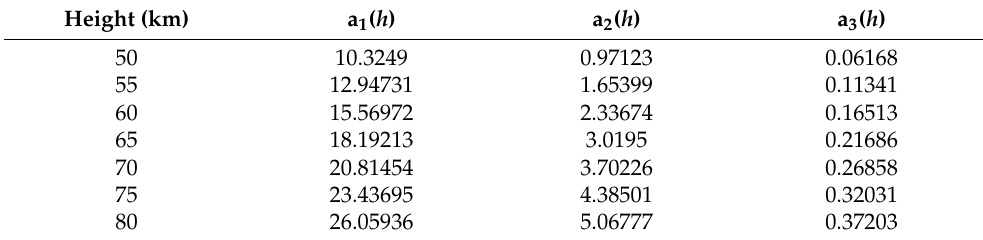
Table 2. Data of the selected